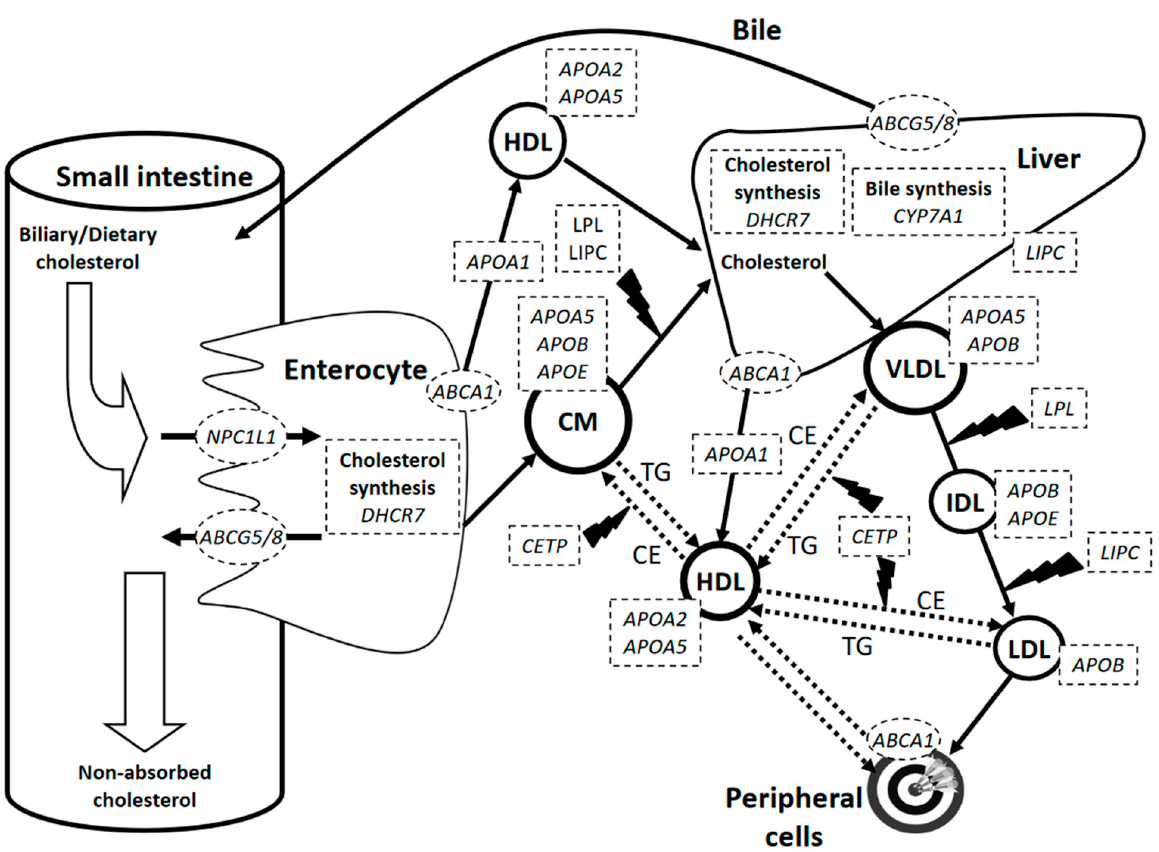
Figure 1. Summary of genes of lipid metabolism and transport pathways involved in the variability of circulating cholesterol concentrations in response to diets. Genes displayed are those for which significant SNP–diet interactions have been reported recently (2014–2020). ABCA1 , ATP binding cassette subfamily A member 1 ; ABCG5/8 , ATP binding cassette subfamily G member 5/8 ; APOA1, apolipoprotein A1 ; APOA2 , apolipoprotein A2 ; APOA5 , apolipoprotein A5 ; APOB , apolipoprotein B ; APOE , apolipoprotein E ; CE, cholesteryl esters; CETP , cholesteryl ester transfer protein ; CYP7A1 , cholesterol 7-alpha-hydroxylase ; DHCR7